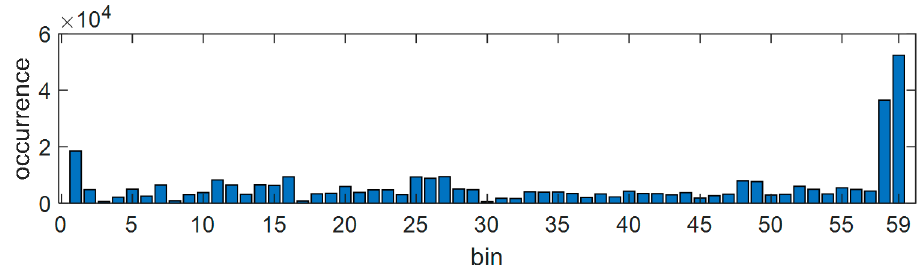
Figure 3. Distribution of uniform and nonuniform LBP codes in a mammogram.